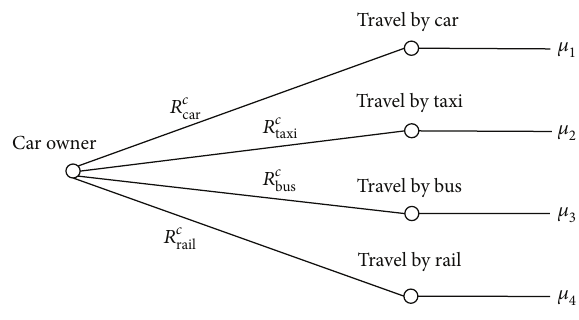
Figure 2: Car Owner Travel Mode Choice Subgame.